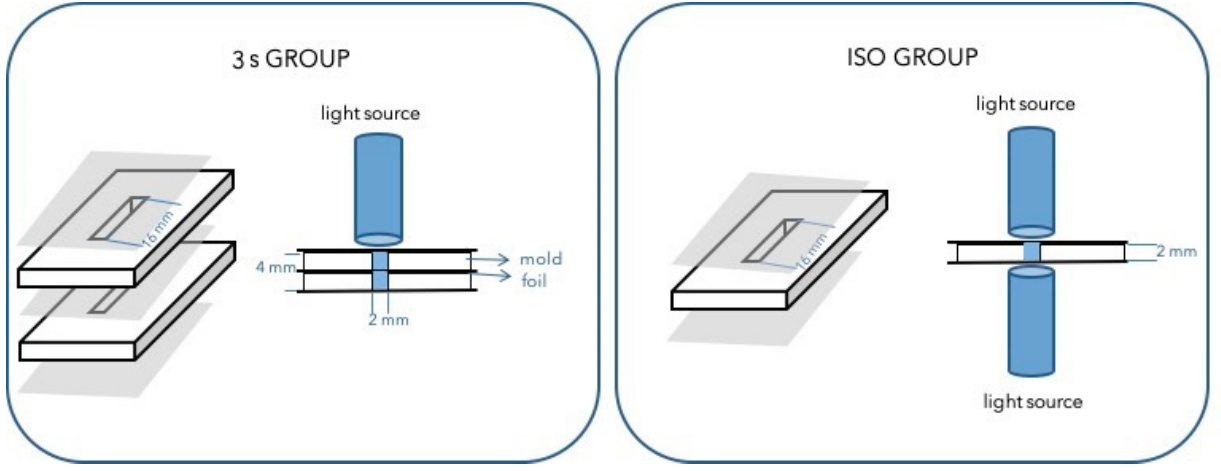
Figure 1. Experimental setup for two polymerization protocols.